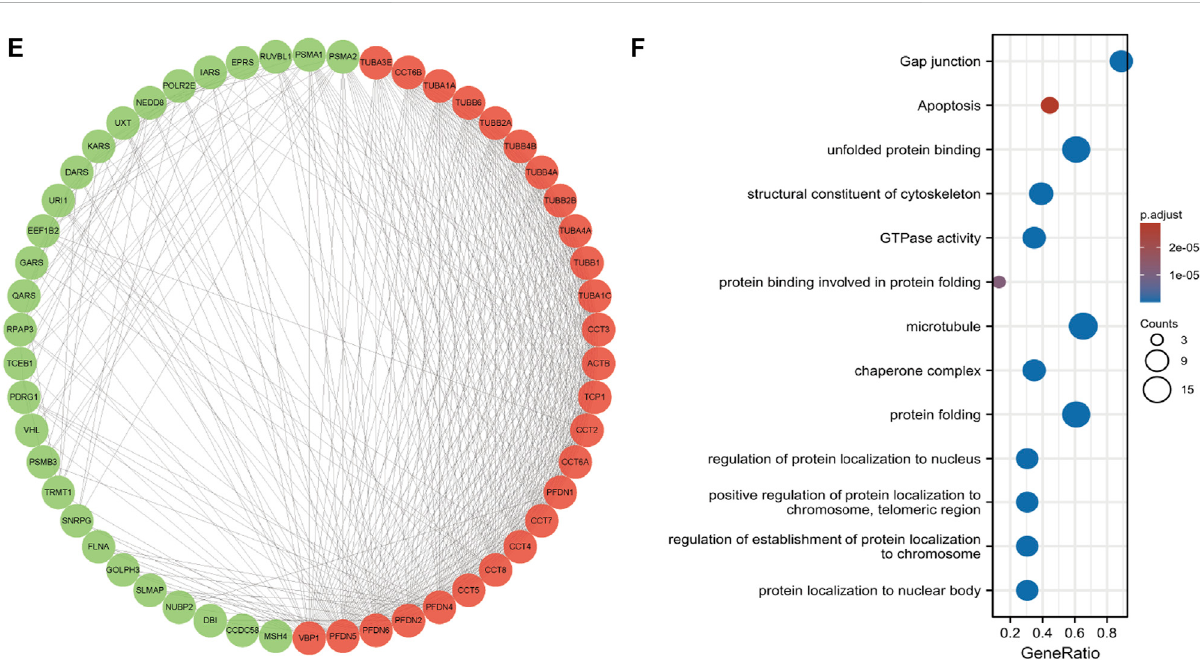
FIGURE 5 Enrichment plots from GSEA and PPI network of PFDN1/2/3/4. Results of GSEA showed that cell cycle checkpoint, G2-M phases, Rho GTPase activation,andGPCRligandbindingwereoverlappingfunctionswithPFDN1/2/3/4alterations.Thesefunctionsalsoweresigni fi cantlyenrichedinthe high-PFDN1 expression group (A) , in the high-PFDN2 expression group (B) , in the high-PFDN3 expression group (C) , and in the high-PFDN4 expression phenotype (D) . (E) Cytoscape MCODE app selected 50 genes. (F) GO analysis of PFDN1-/2-/3-/4-related